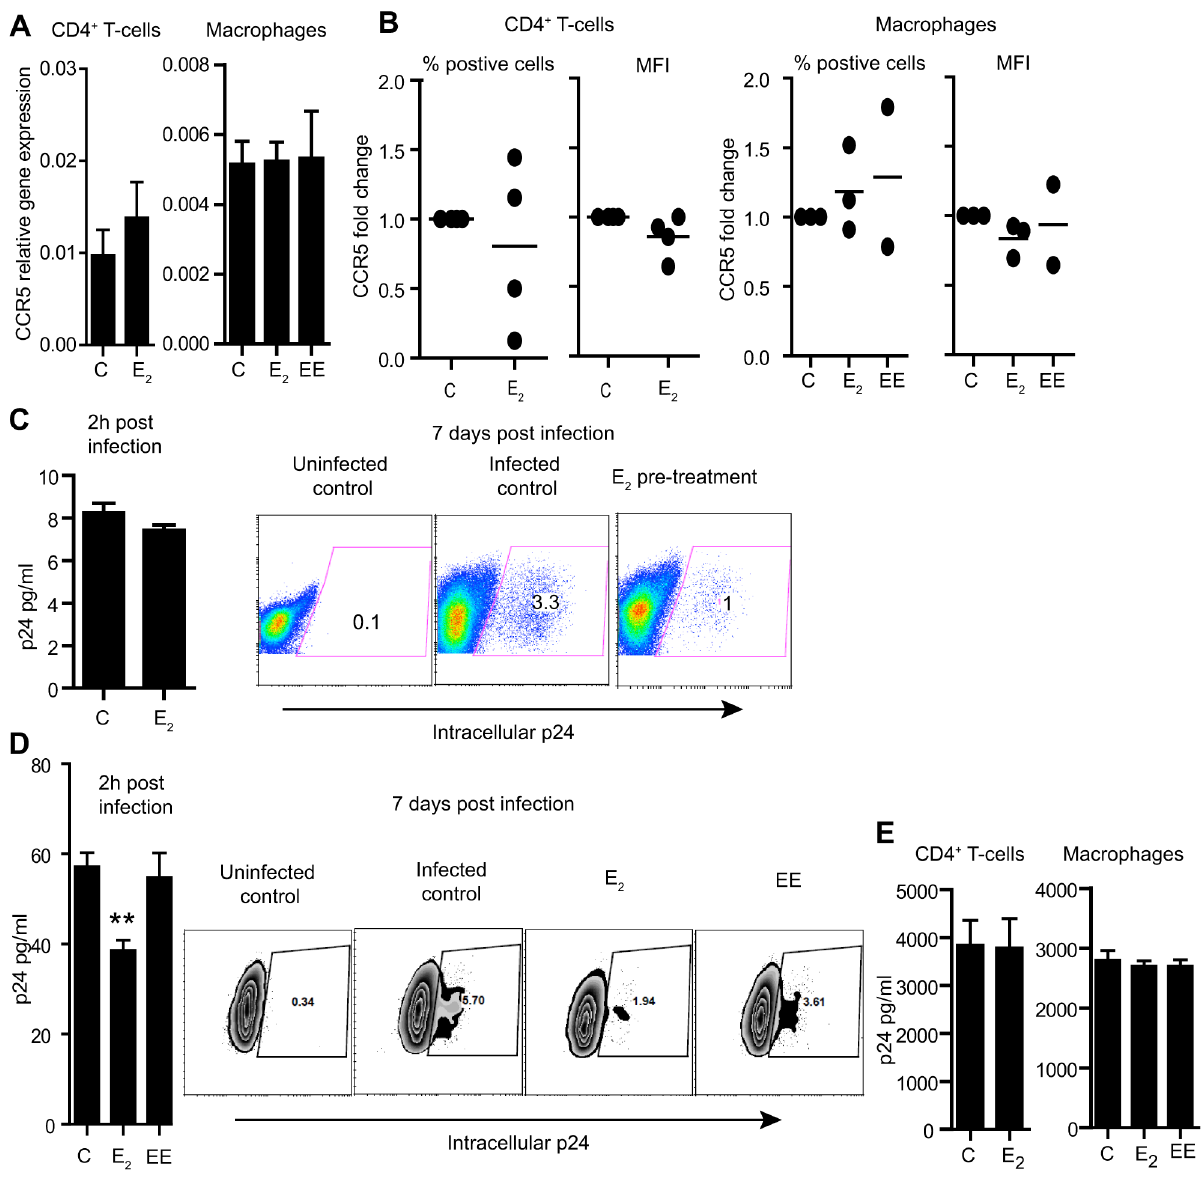
Figure 5. Effect of E 2 on CCR5 expression and viral entry. A) CCR5 expression by RT-PCR. Bars represent mean 6 SEM from 4 different donors. B) Surface expression of CCR5 after treatment with E 2 or EE compared to control. C) p24 detection in cell lysates from CD4 + T-cells 2 h after infection (N=4) and intracellular p24 expression 7 days after infection. D) p24 detection in cell lysates from macrophages 2 h after infection (N=3) and intracellular p24 levels 7 days after infection. E) Released p24 in the culture media 3 days after infection with VSV-G pseudotyped HIV. Bars represent mean 6 SEM from 4 independent experiments with CD4 + T-cells and 3 with macrophages from different donors.